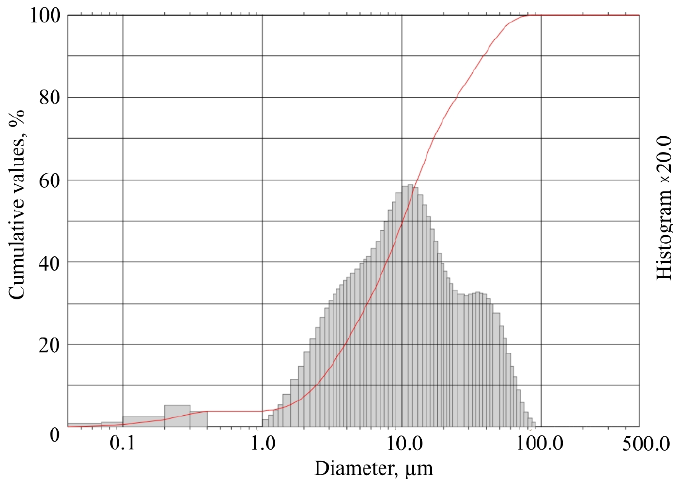
Figure 3. Distribution of MKA particles by size.